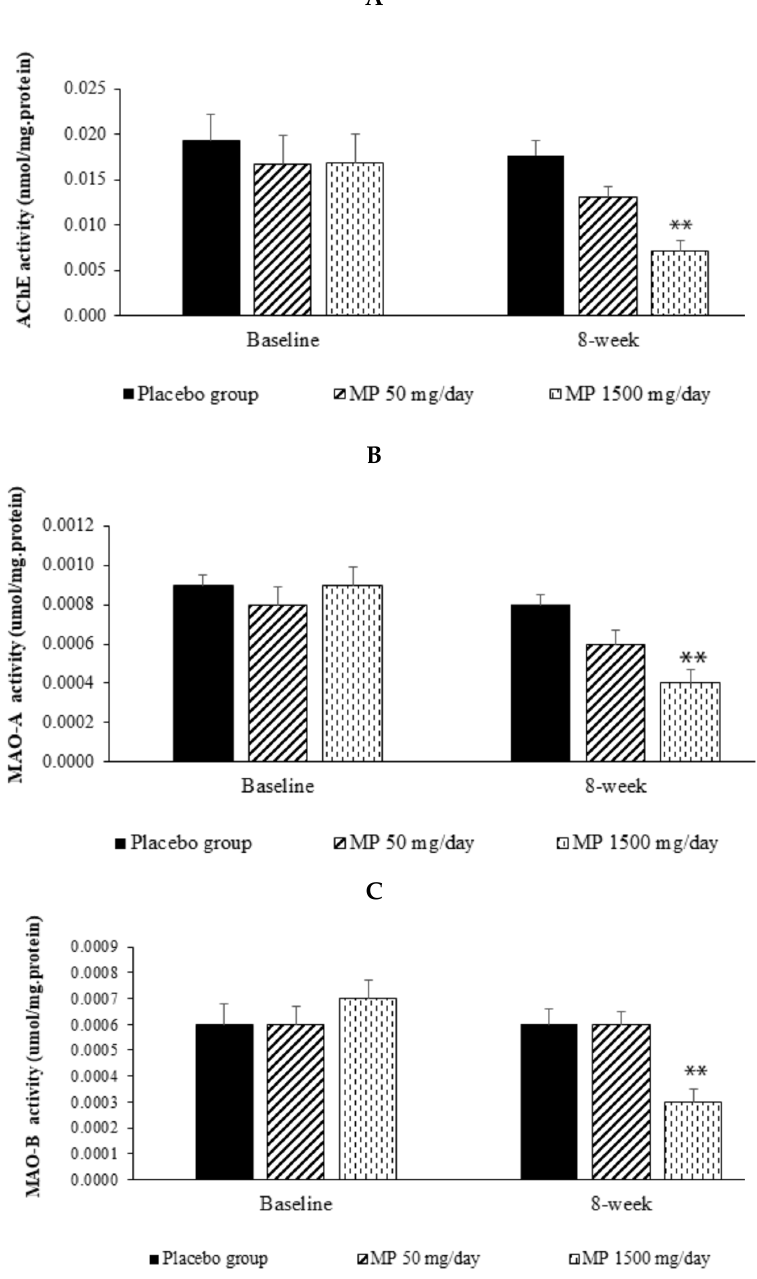
Figure 3. The effect of various doses of the developed supplement containing the combined extract of Polygonum odoratum and Morus alba leaves on the activities of the neurotransmitter inactivation enzymes in the subjects who consumed the assigned substances at the end of the 8-week study period. ( A ) Acetylcholinesterase (AChE). ( B ) Monoamine oxidase type A (MAO-A). ( C ) Monoamine oxidase type B (MAO-B) (N = 15/group). Values are expressed as mean ± SD. Data are analyzed using ANOVA. ** p -value < 0.01; compared to the placebo group.